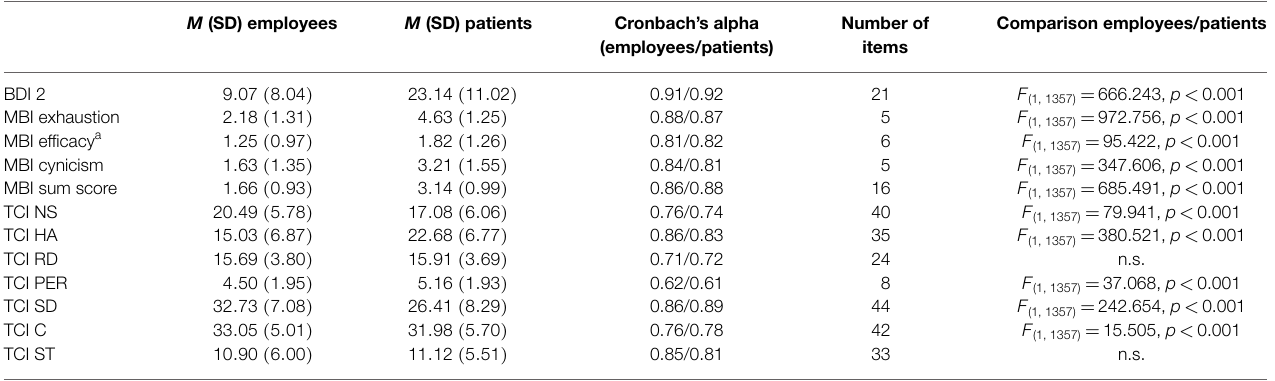
TABLE 1 | Means and SDs of employed participants’ ( N = 944) and patients’ ( N = 425) questionnaire responses plus reliability (coefficients in terms of Cronbach’s alpha) of the used scales are presented . M (SD) employees M (SD) patients Cronbach’s alpha